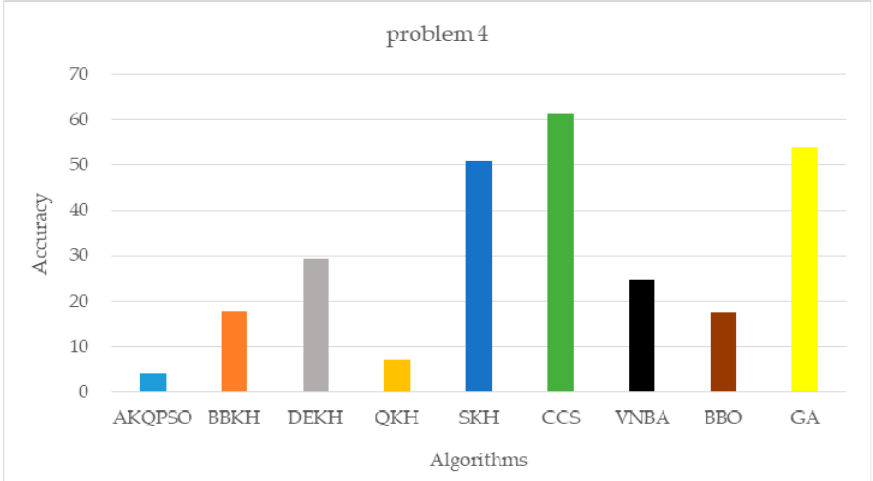
Mathematics 2020 , 8 , x FOR PEER REVIEW Figure 6. Accuracy of AKQPSO and other algorithms on problem 4: Rastrigin’s function.